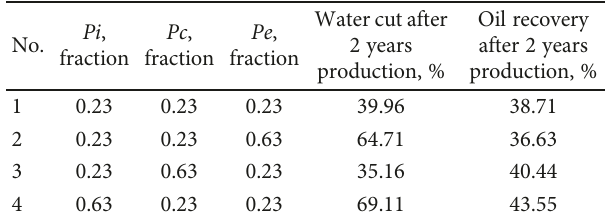
Table 2: Schemes parameters of all streamline